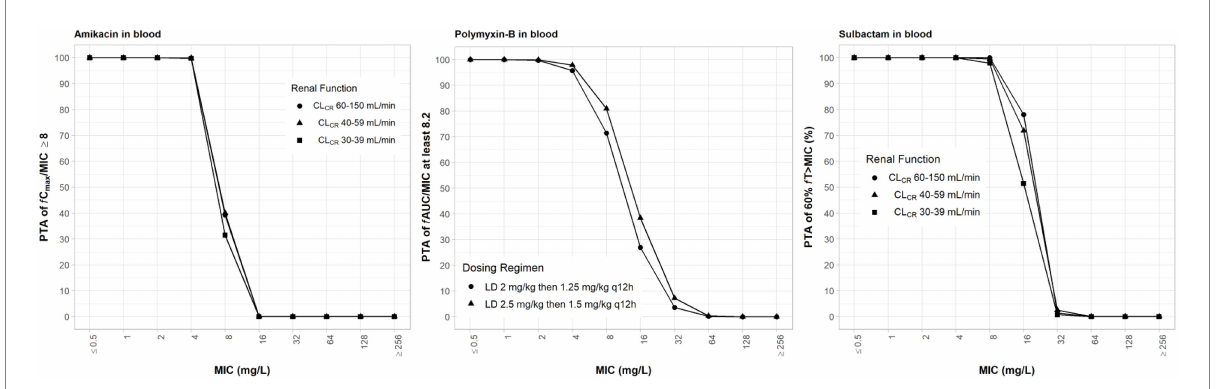
FIGURE 2 Probability of target attainment (PTA) of 60% f T >MIC and 8 f C max /MIC for sulbactam and amikacin dosing regimens by renal function category, respectively, and PTA of f AUC/MIC of at least 8.2 for polymyxin-B dosing regimens. PTA values were computed based on steady-state drug concentrations in the blood. LD, loading dose; CL CR , creatinine clearance.